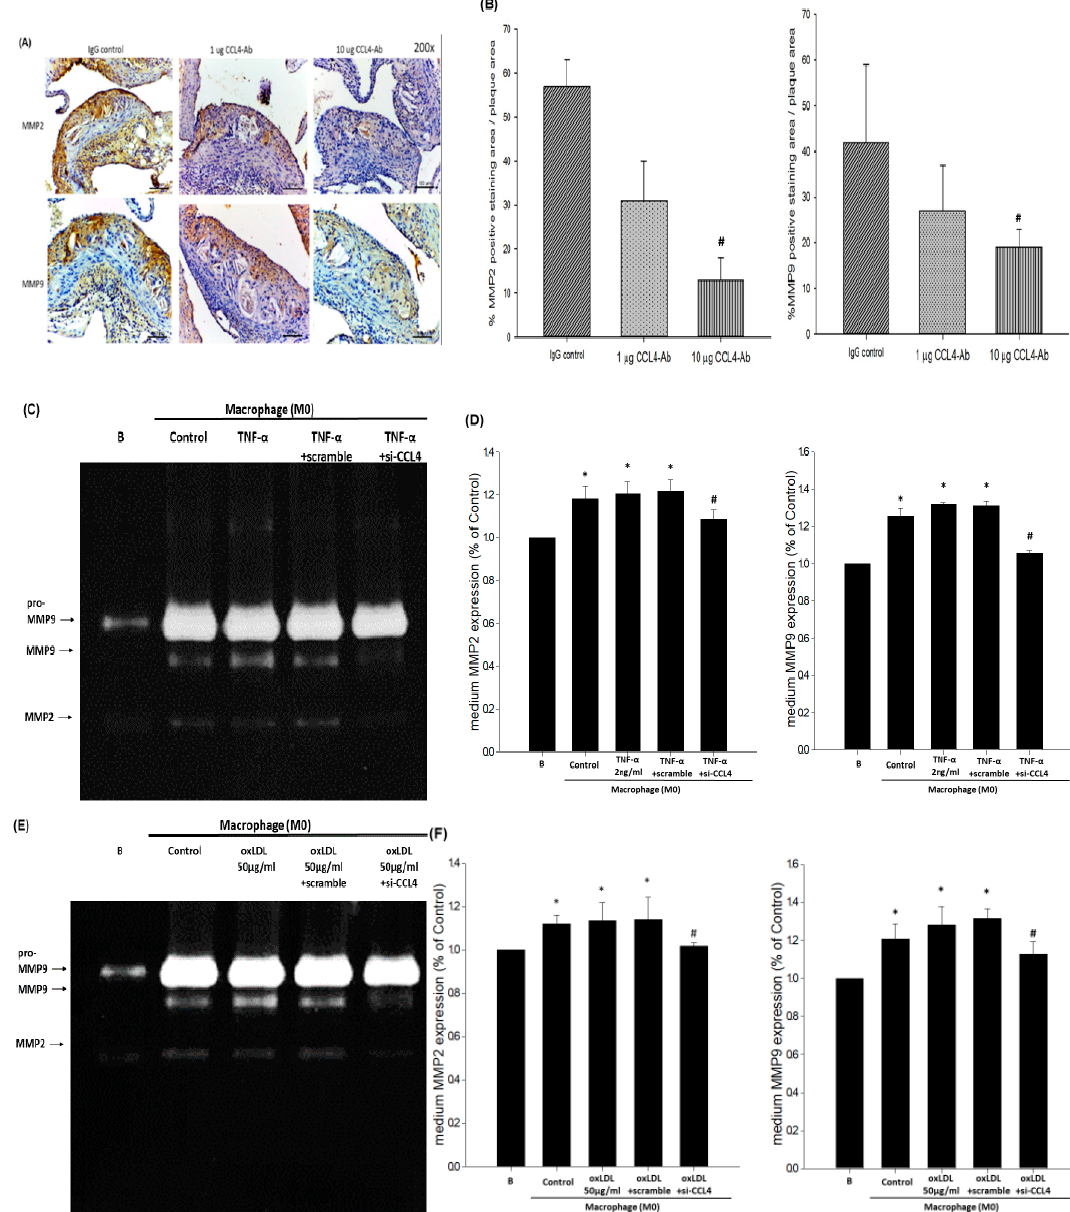
Figure 4. CCL4 blockade down-regulated TNF- α - and oxidized low-density lipoprotein (ox-LDL)-induced matrix metalloproteinase (MMP)2 and MMP9 expression. The CCL4 inhibition groups showed reduced MMP2 and MMP9 expression in plaques ( A , 200× magnification, scale bars = 100 μ m). Quantification of MMP2-positive area/plaque area (%) and MMP9-positive area/plaque area (%) indicating that treatment with 10 μ g CCL4 antibody reduced MMP2 and MMP9 expressions in plaques ( B , n = 6 in each group). # p < 0.05 compared with the IgG 2A isotype control group. MMP9 and MMP2 activities in the culture medium were determined using SDS-PAGE gelatin zymographic analysis ( C , E ). Both MMP2 and MMP9 activities were increased after phorbol 12-myristate 13-acetate (PMA) stimulation. The TNF- α - and ox-LDL-induced MMP2 and MMP9 activities were decreased in the CCL4 siRNA-treated group ( n = 3; D , F ). Basal represented untreated THP-1 cell and control represented THP-1 cell were incubated with PMA to induced M0 phase macrophages. * p < 0.05 compared with the basal group. # p < 0.05 compared with the TNF- α - or ox-LDL-stimulated group.